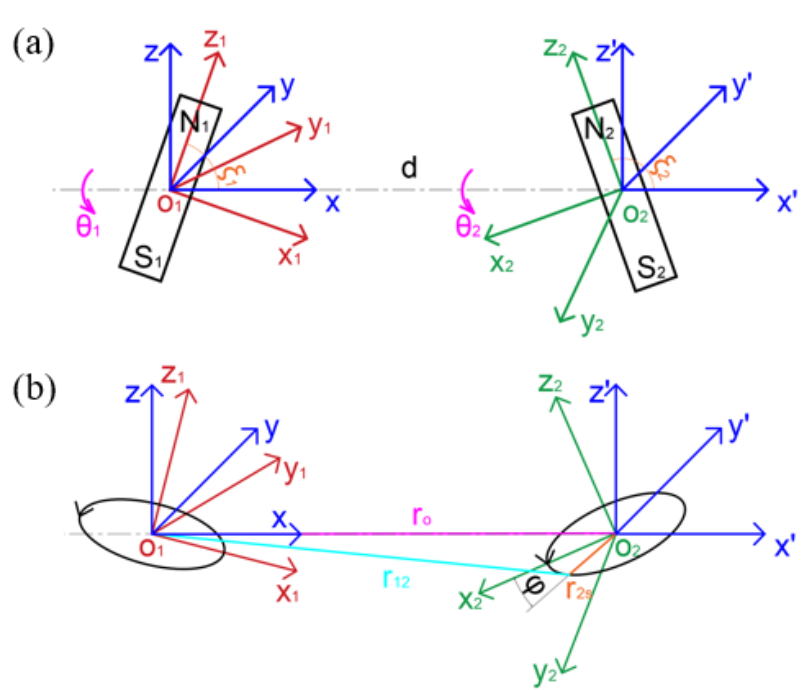
Figure 3. The angular relationship between the global coordinate systems and the body coordinate systems ( a ) and the vector relationship between the coils ( b ). The distance between the centers of two magnetic dipoles is expressed by d . According to the Ampere force formula, in the global coordinate system o-xyz, the electromagnetic force of coil 2 from coil 1 can be obtained by Equation (11). (cid:73) → F 12 = The electromagnetic torque of coil 2 is the cross product of the arm and the electro- magnetic force, as shown in Equation (12).